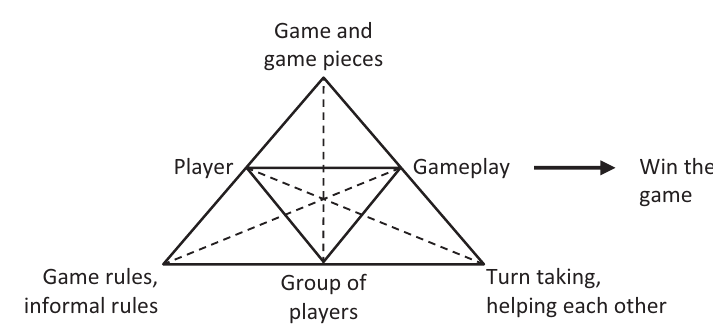
Figure 4. The activity of playing a game described as an activity